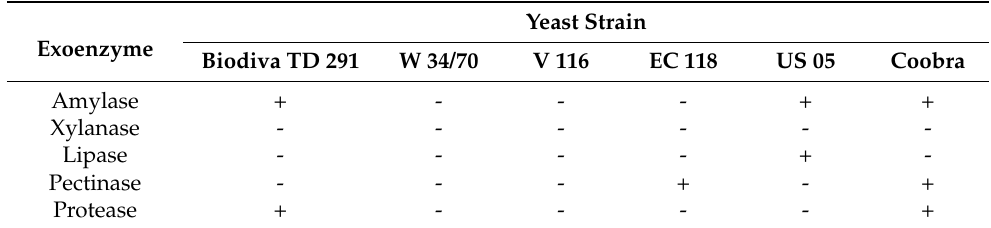
Table 5. Qualitative lytic exoenzyme production in antagonistic yeast